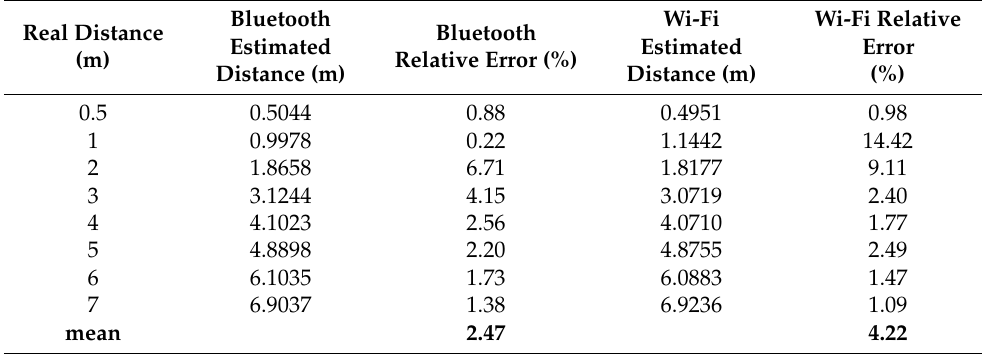
Table 14. Comparison results between real and estimated distance values measured with Bluetooth and Wi-Fi.